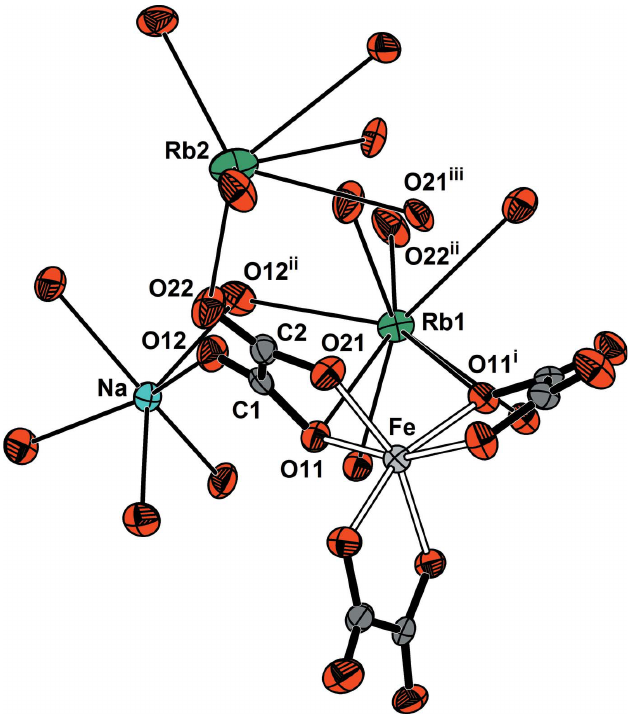
Figure 1 View of NaRb 5 [Fe(C 2 O 4 ) 3 ] 2 showing the atom labels and displacement ellipsoids at the 50% probability level. For clarity, only the minimum number of oxygen ligands around each metal ion has been labelled. The rest of the environmental oxygen atoms are generated through the symmetry operations of the corresponding point groups: C 3 (Fe), C 2 (Rb1), C 3 (Rb2) and D 3 (Na). Iron–oxalate bonds are indicated by double lines and alkali metal–oxygen contacts by single lines. Symmetry codes: (i) (cid:2) y + 1, z + 1 , (cid:2) x + 1 ; (ii) y (cid:2) 1 , (cid:2) z + 3 , (cid:2) x + 1; (iii) (cid:2) y + 5 , (cid:2) x + 5 , (cid:2) z + 1 2 2 2 2 4 4 4